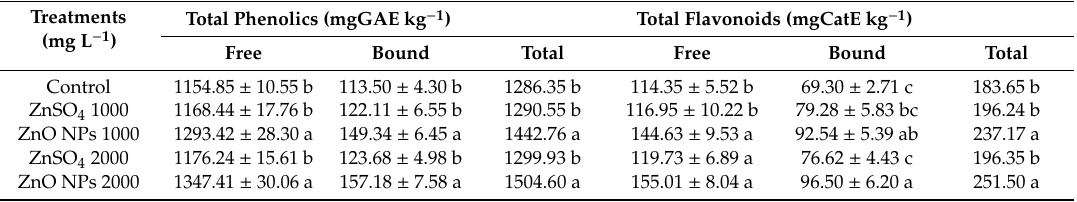
Table 4. Content of total phenols and total flavonoids (soluble + bound) in habanero pepper fruits obtained from plants treated with ZnO NPs and ZnSO 4